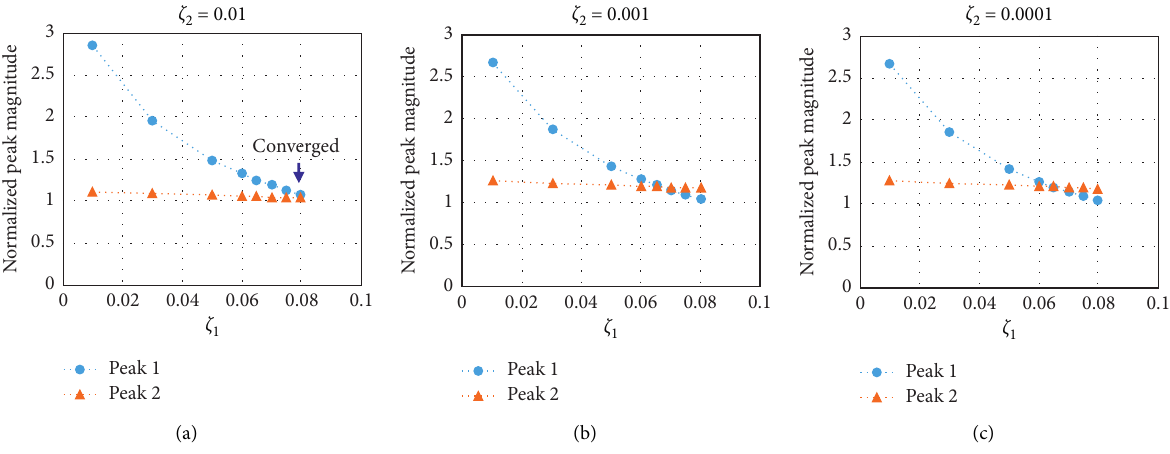
Figure 13: Normalized peak magnitudes against ζ